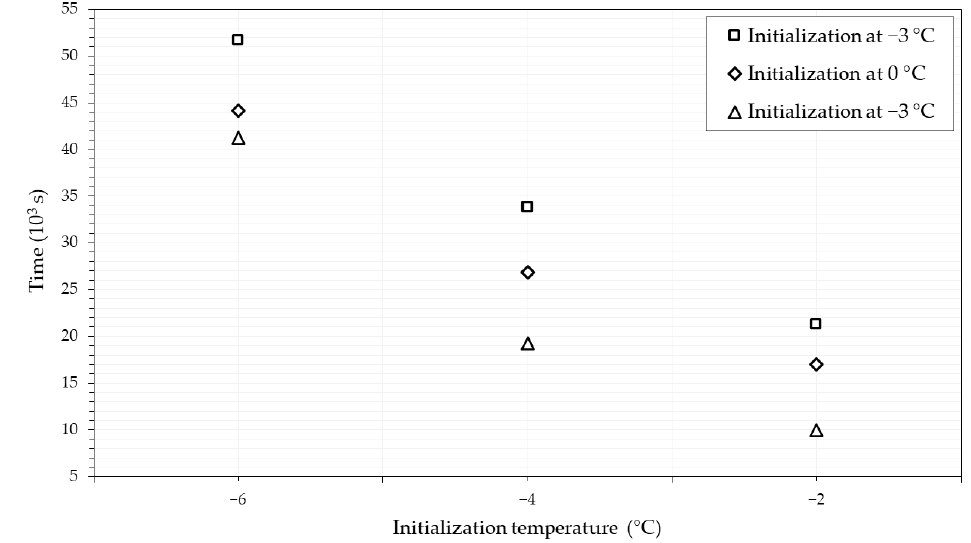
Figure 12. Comparison of time interval required to reach and maintain the average temperature of 3 °C at the asphalt surface with all three initialization conditions. The measured data during year 2020 show that the HRS was operational for 2387 h, which includes the operational hours when there was no risk of snowfall/ice formation. The present study is used as basis to develop a control algorithm for HRS where the sys- tem would be operational only when required. Heat input and operational conditions will